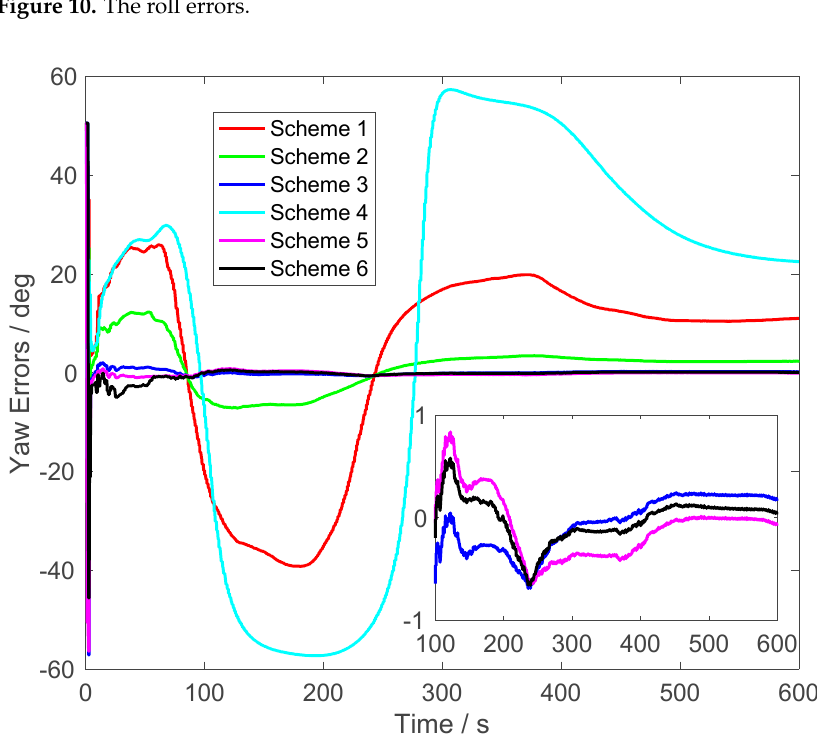
Figure 11. The roll errors.